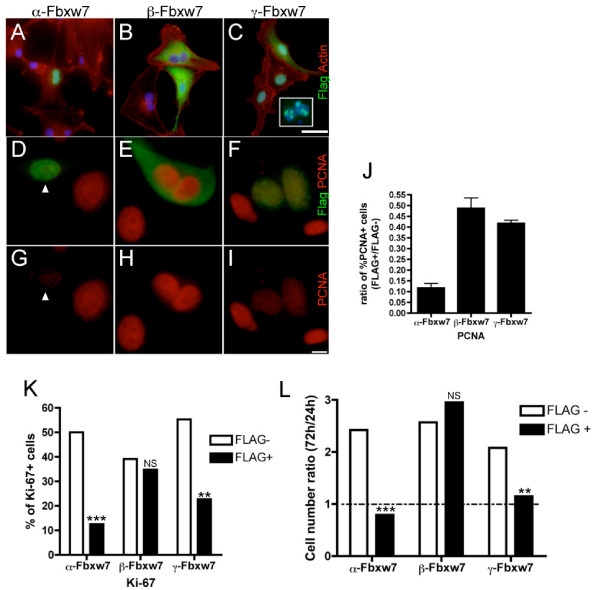
Effect of FBXW7 overexpression in glioma cells. Immunodetection of FLAG-Fbxw7 (green) in U87, 48 hours after transfection with plasmids encoding each of the three isoforms α (A), β (B), γ (C). Nuclei are labeled with DAPI (blue) and actin cytoskeleton with rhodamin-coupled phalloidin (red), bar = 50 μm. α-Fbxw7 localizes to the nucleus, β-Fbxw7 is cytoplasmic, γ-Fbxw7 localization varies. It is restricted to the nucleolus at low levels (insert) and leaks in the nucleus and in the cytoplasm at higher doses. Example of PCNA detection (red) in U87 cells overexpressing FLAG-Fbxw7 (green) α (D), β (E), γ (F). In lower panels (G-I), only the red signal in the same fields is shown. An example of α-Fbxw7-positive PCNA-negative cell is shown with arrowhead. bar = 10 μm. Quantification analysis of PCNA expression 48 h after transfection (J). Scoring was established on >150 cells per assay. The results (mean of two independent experiments, ± SEM) are expressed as the ratio of PCNA+ cells in FLAG+ versus FLAG- cells from the same transfection well. Quantification analysis of Ki-67 expressing cells in FLAG- and FLAG+ cells 48 h after transfection (K). Statistical analysis was performed using the Fisher's exact test (n > 150 cells for each group). The experiment was repeated twice with similar results. Cell growth after transfection with each isoform expression plasmid (L). For each assay, cells were stained with DAPI and anti-FLAG antibody 24 h and 72 h after transfection. FLAG positive and negative cells were scored from 20 independent 40×-magnified fields and their 72 H/24 h ratio compared. Cells overexpressing nuclear isoforms α and γ are significantly counterselected. Statistical analysis was performed using the Fisher's exact test (n > 1000 cells for each assay). The experiment was repeated twice and analyzed once after 48 h with similar results.